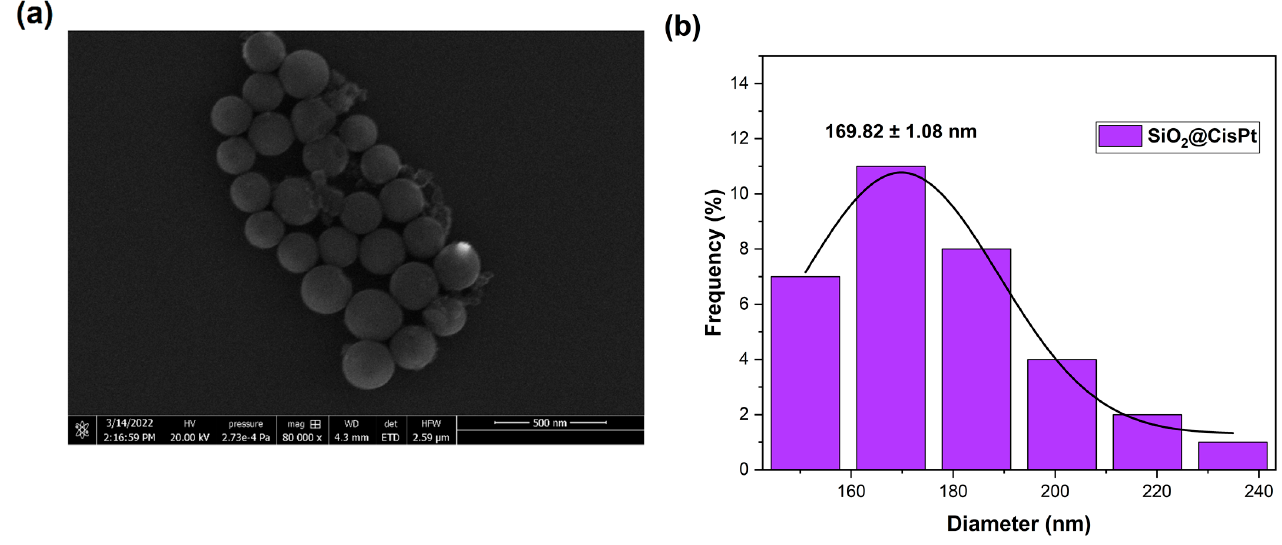
Figure 2. Representative SEM image of SiO 2 @CisPt NPs ( a ) and the corresponding size distribution ( b ) of SiO 2 @CisPt